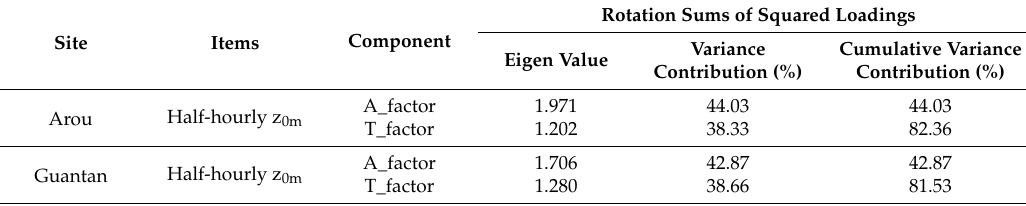
Table 4. The contributions of factors for z 0m